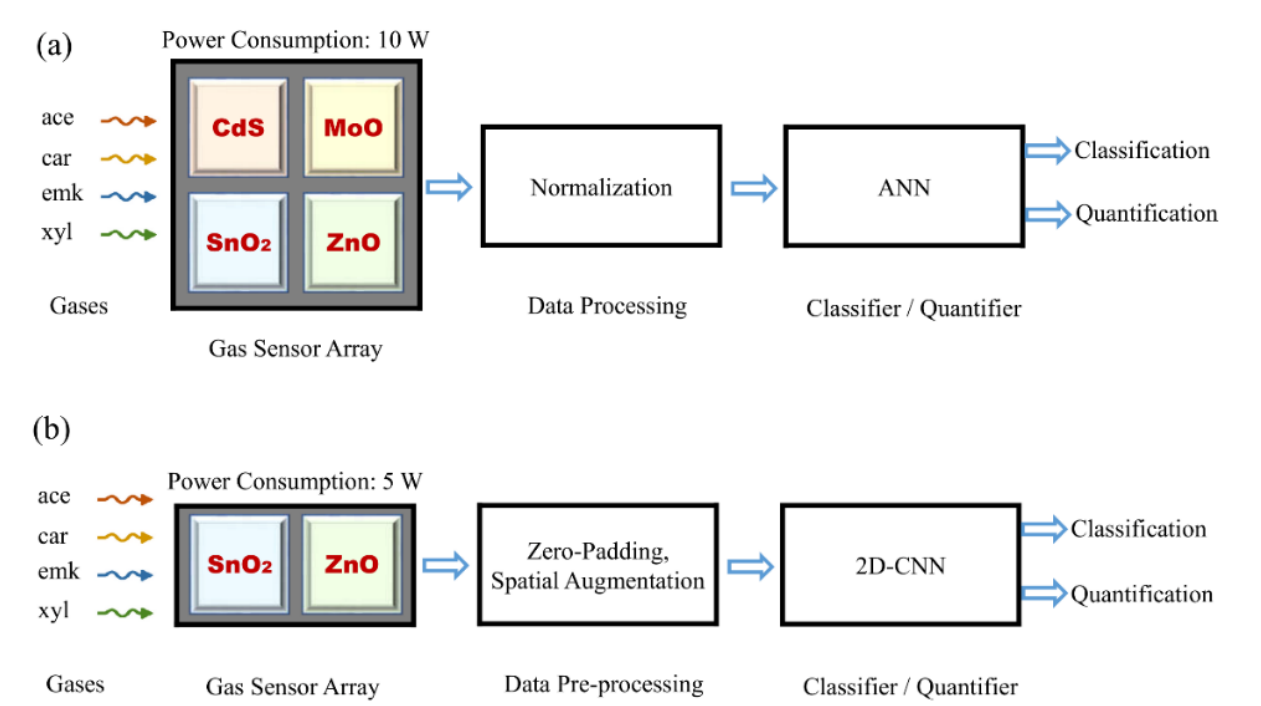
Figure 1. Schematic block diagrams of an electronic nose; using traditional ANN which are too com- plex due to usage of only fully connected layers resulting in a large number of trainable parameters ( a ); using the proposed sensor array optimization approach suitable for resource-constrained 6G-IoT scenarios incorporating a simpler 2D-CNN which results in less trainable parameters due to usage of convolutional layers than traditional ANN ( b